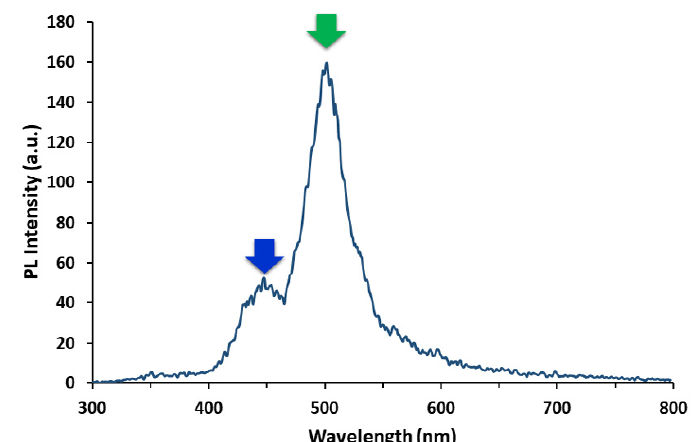
=410 nm at room temperature 𝜆𝜆𝜆𝜆 𝑒𝑒𝑒𝑒𝑒𝑒𝑒𝑒